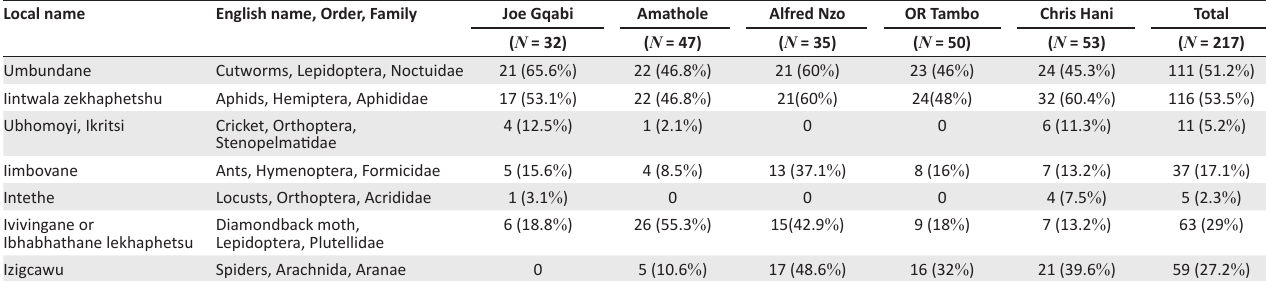
TABLE 4: Arthropod pests of cabbage in the study areas. Local